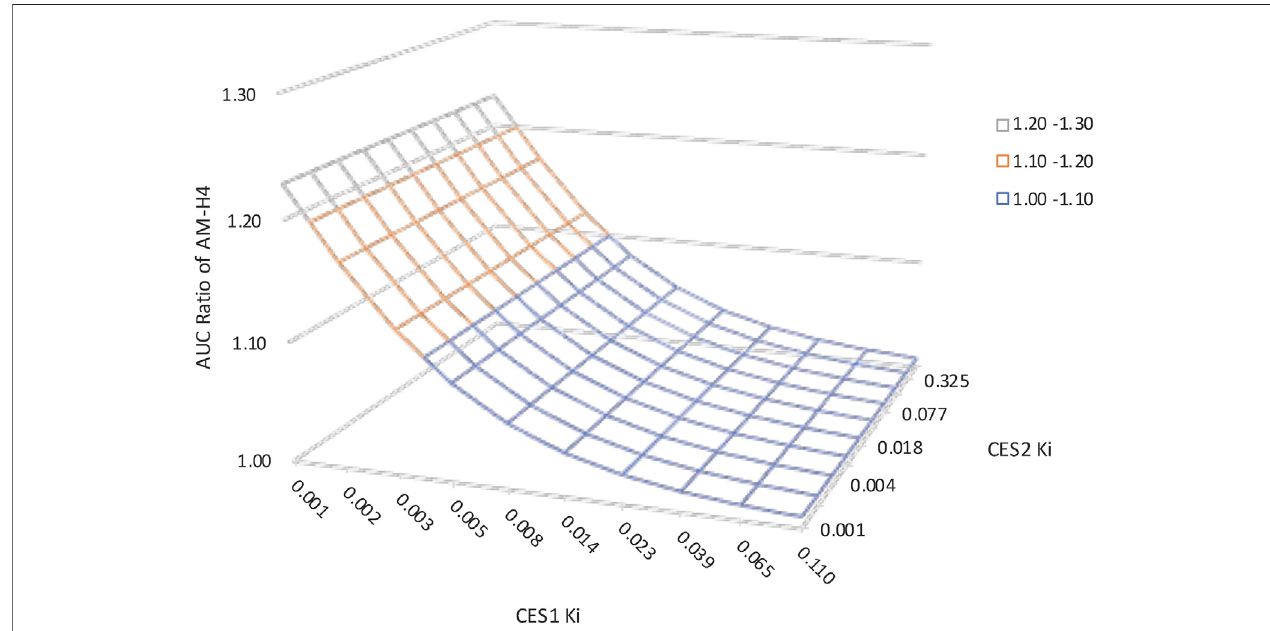
FIGURE 5 | Sensitivity analysis suggesting the impact of carboxylesterases K i of simvastatin on vicagrel predicted AUC 0-t ratios. K i on CES1 ranged from 0.001 – 0.11. K i on CES2 ranged from 0.001 – 0.67.